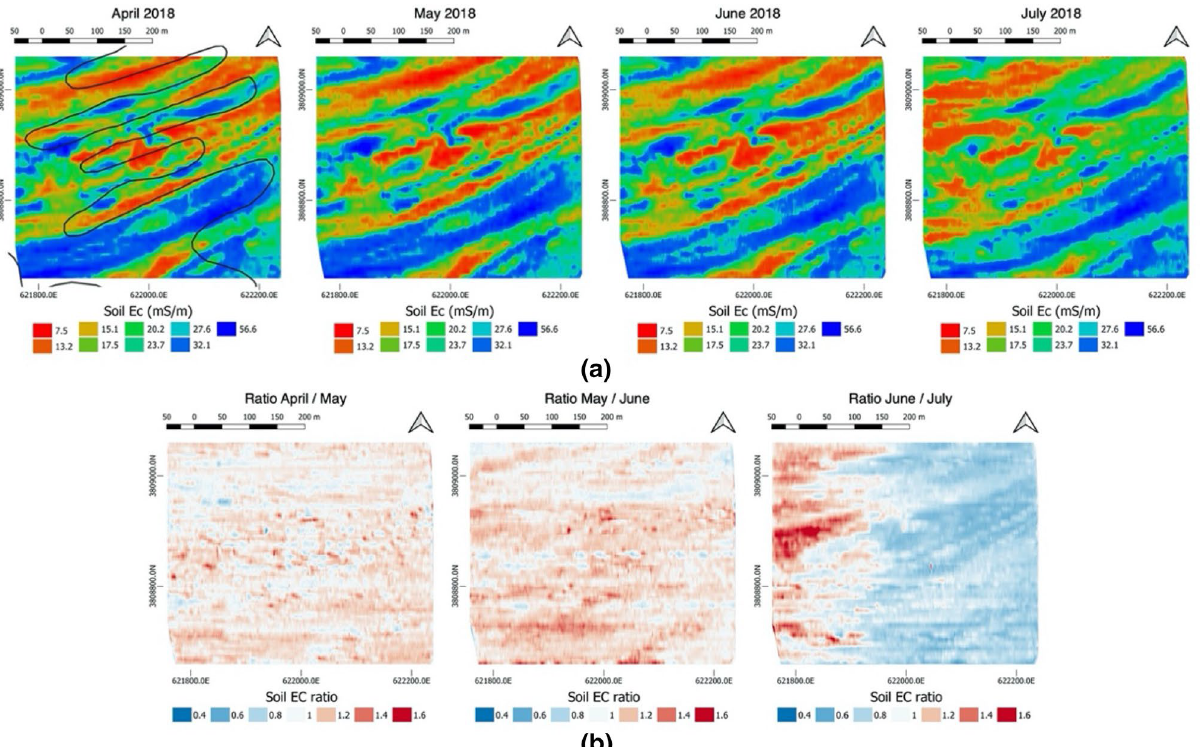
Figure 7. ( a ) Time-series of soil EC a acquired during the growing season. ( b ) Maps of the soil EC a ratio between adjacent data collection. The soil EC a seems consistent between April and June, showing an almost uniform slight decrease (ratio about 1.2). A strong variation can be noticed between June and July, with the west area becoming dryer. The black lines overlaped on the april acquisition represent the gSSurgo boundaries. Maps made with QGIS (v 3.6, https:// www. qgis. org) 36